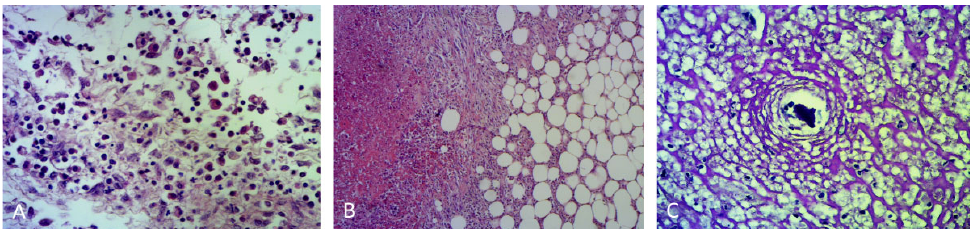
Figure 7. ( A ) Histological examination of the cyst wall showed fibroblasts, neutrophils and cell debris. ( B ) Sections of ureter and renal pelvis showed intense fibroblastic reaction and necrosis; ( C ) neutrophils surrounding debris of lithiasis deposits were also observed. HE,